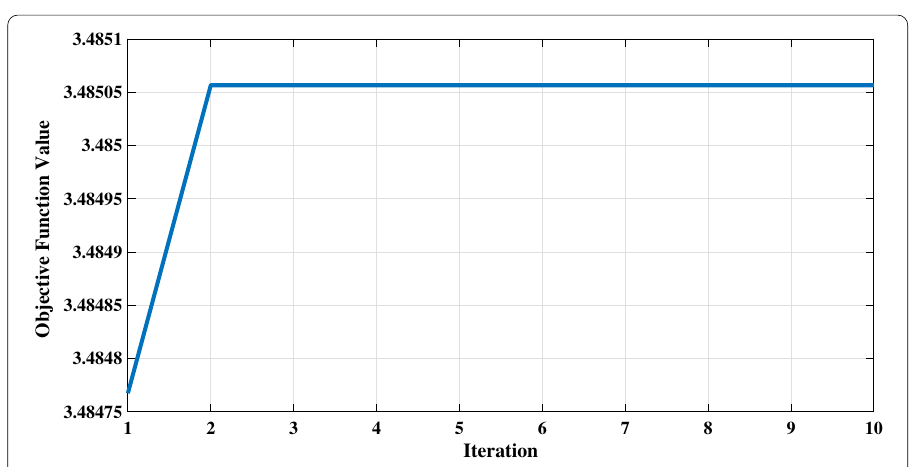
Fig. 8 Objective function value versus iteration